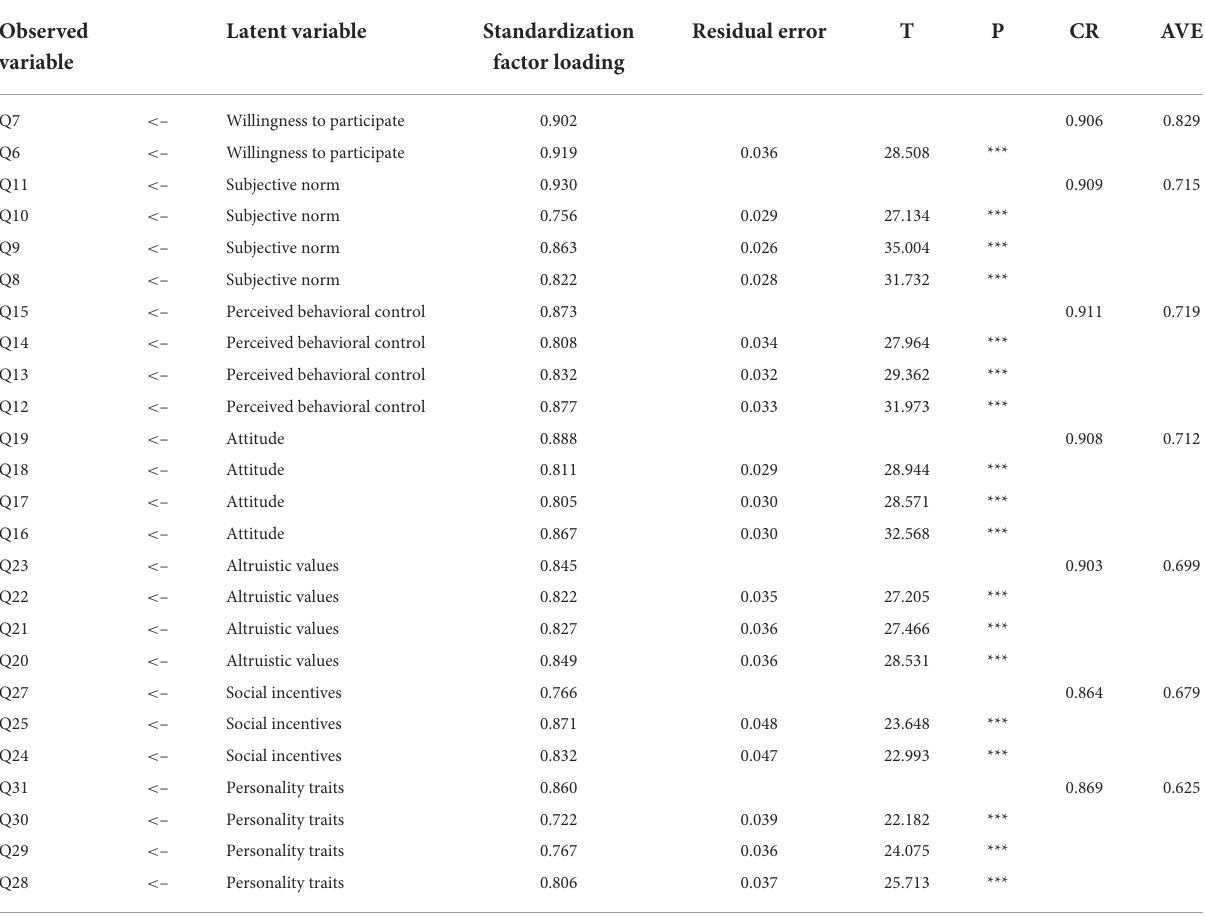
TABLE 4 Confirmatory factor analysis results.